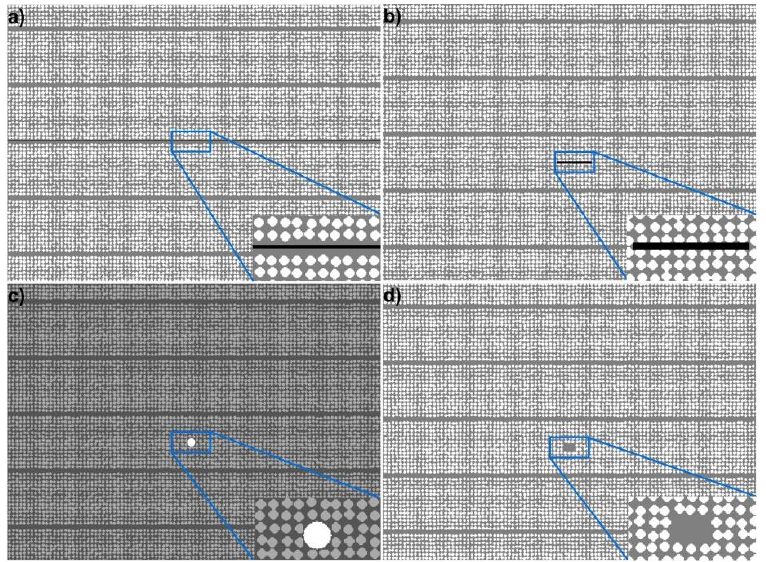
Figure 2. Simulated defective structures: ( a ) total debonding at the ply junction (black line); ( b ) delam- ination inside the ply (black rectangle); ( c ) foreign body representing grease (white disk); ( d ) broken fibers (grey